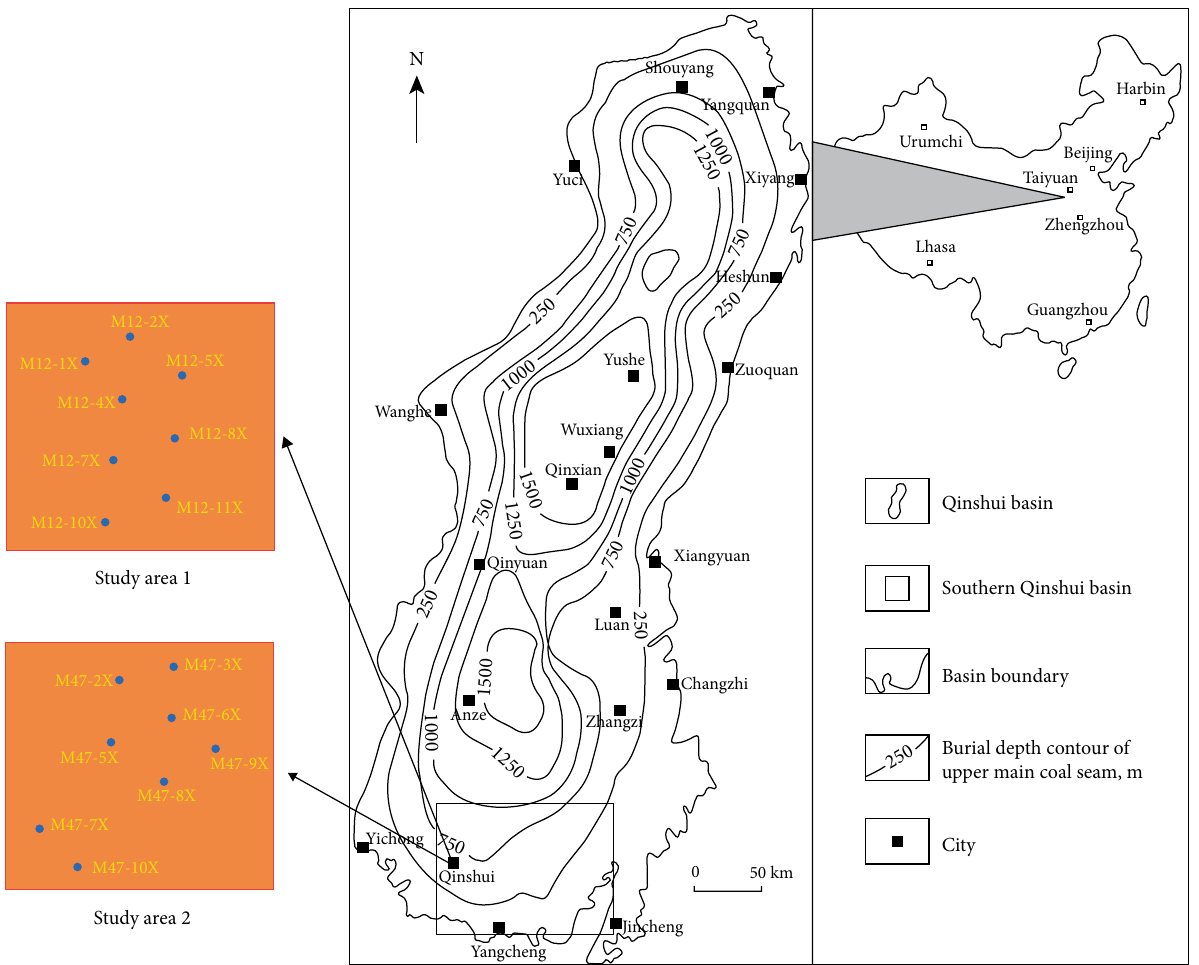
Figure 2: Location of the target block in China and two study areas with corresponding wells